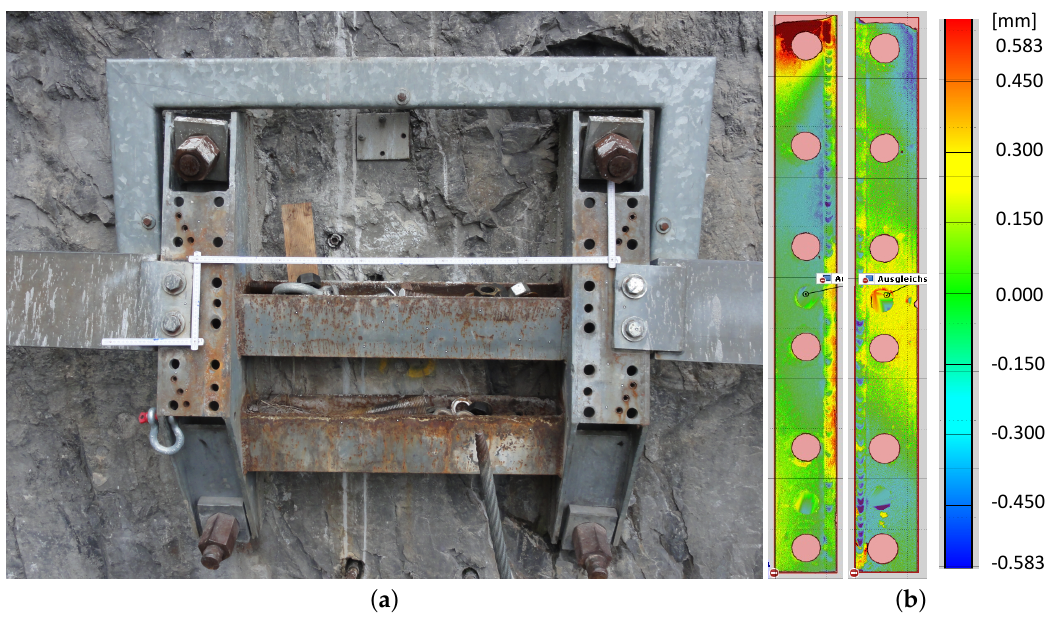
Figure 3. ( a ) Two strip foundations mounted on the rock wall; ( b ) Orthogonal deviation of the surface of the two strip foundations from a common plane, determined using a high precision laser